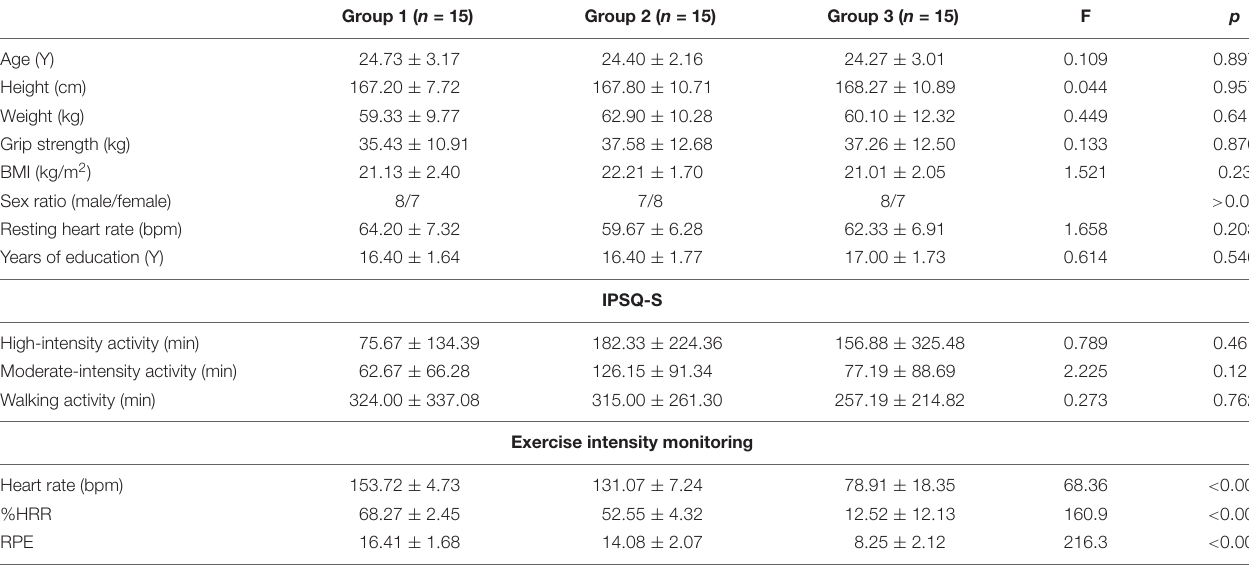
TABLE 1 | Demographics and clinical characteristics and exercise intensity monitoring of the